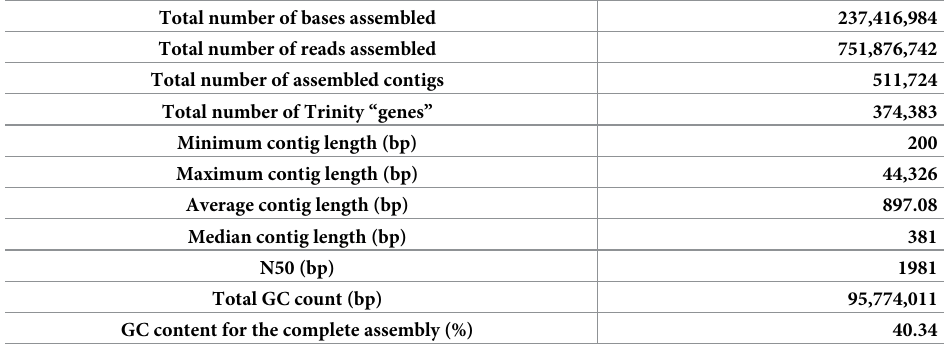
Table 2. G . bimaculatus prothoracic ganglion transcriptome assembly statistics.